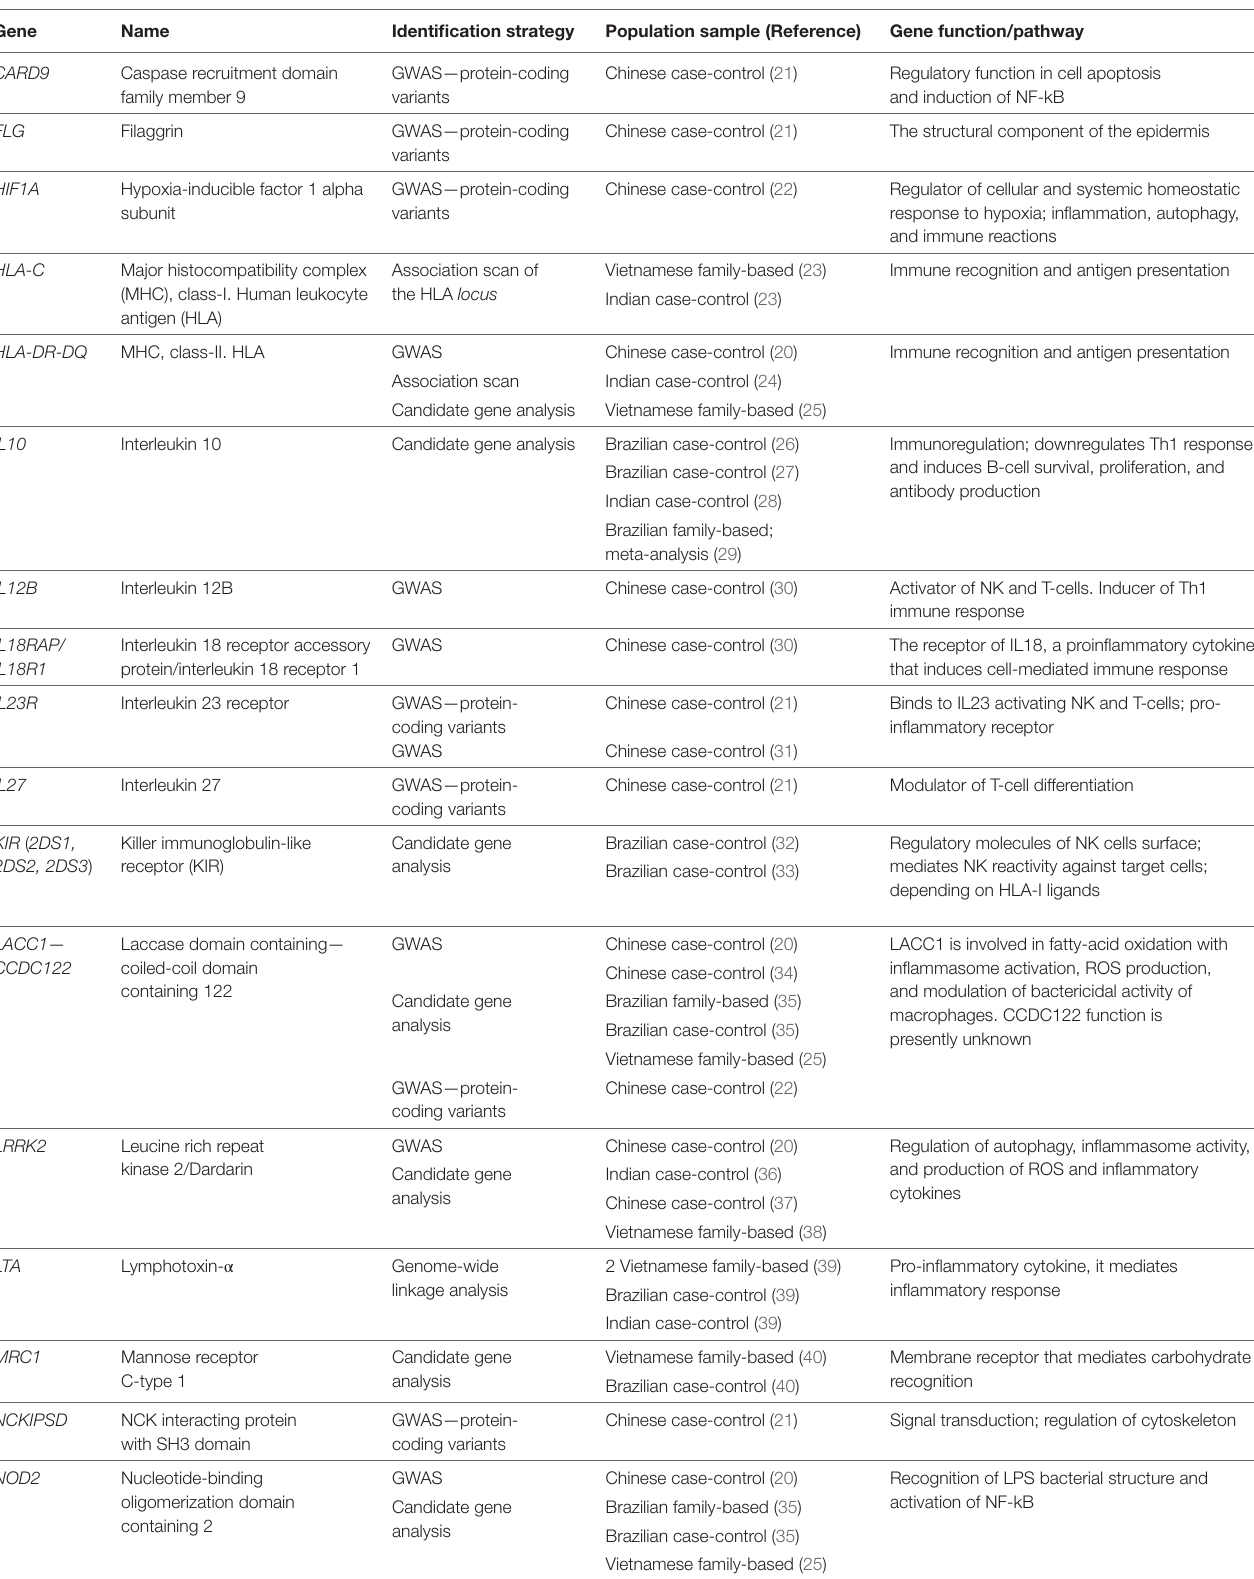
TAbLe 1 | Leprosy-associated genes with functional evidence or replicated